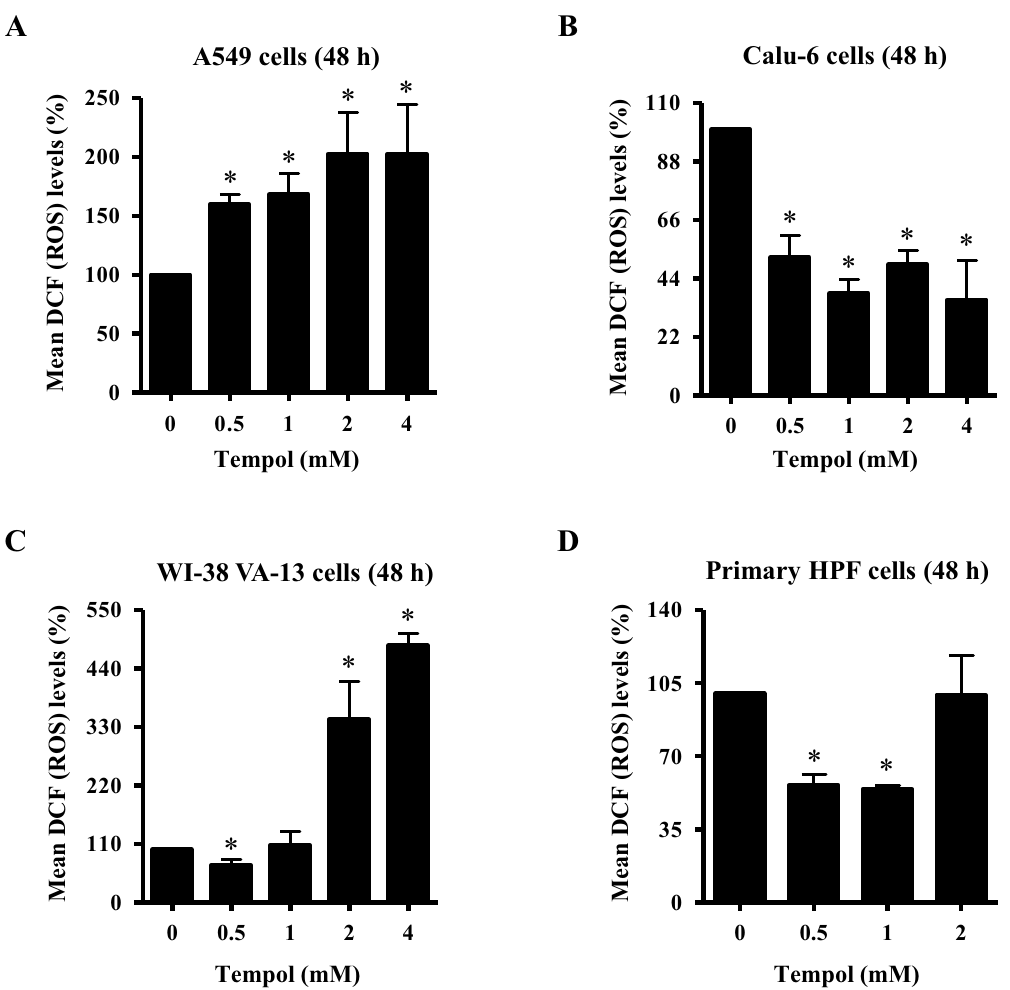
Figure 1. Effects of Tempol on intracellular ROS (DCF) levels in lung cancer and normal cells. Cells in the exponential growth phase were incubated with the indicated concentrations of Tempol for 48 h. Intracellular ROS (DCF) levels in lung cells were measured using a FAC Star flow cytometer. The graphs indicate mean ROS (DCF) levels (%) in A549 cells ( A ), Calu-6 cells ( B ), WI-38 VA-13 cells ( C ), and primary HPF cells ( D ). *p < 0.05 compared with untreated